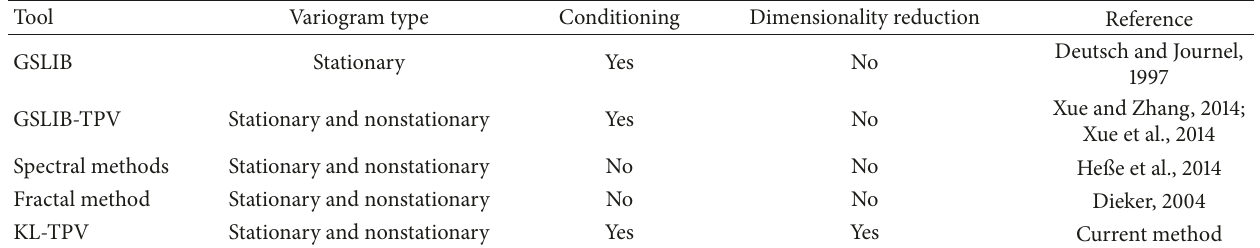
Table 1: Comparison of the existing methods to generate random fractal